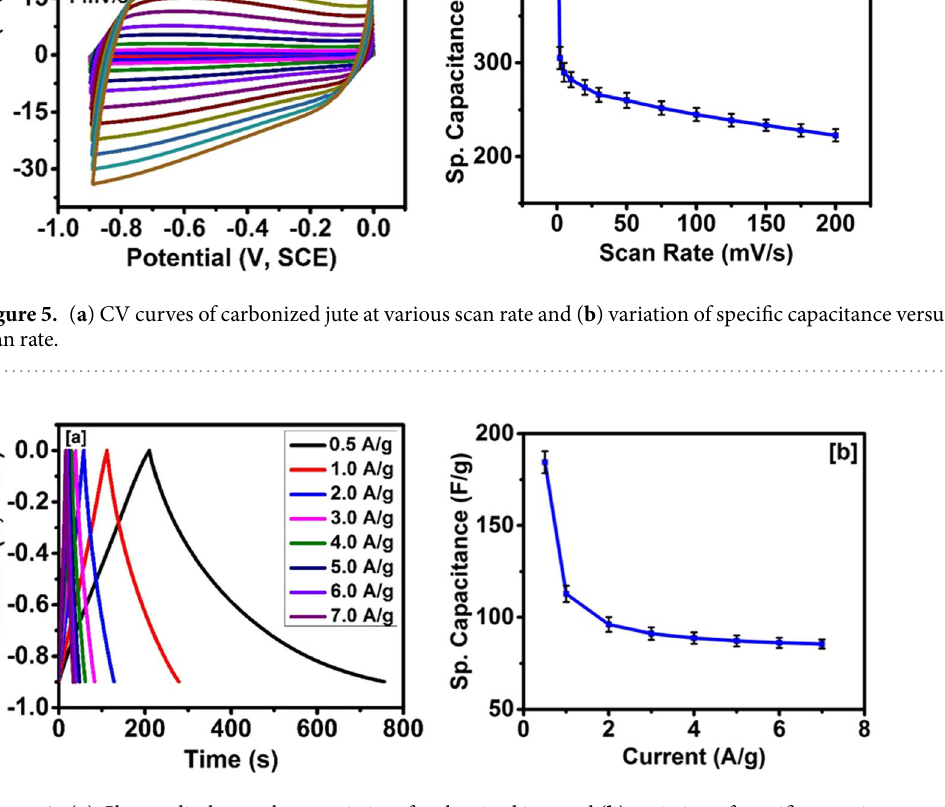
Figure 6. ( a ) Charge-discharge characteristics of carbonized jute and ( b ) variation of specific capacitance versus applied